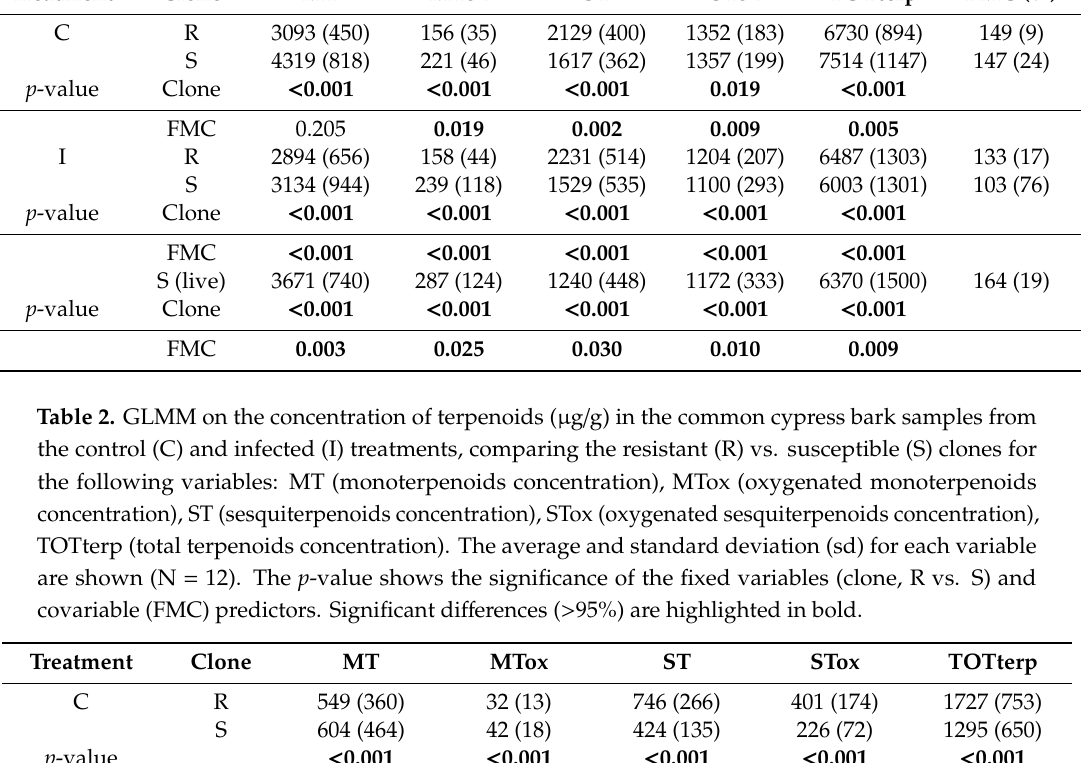
Table 1. Generalized linear mixed models (GLMM) on the concentration of terpenoids ( µ g / g) in common cypress leaf samples from the control (C) and infected (I) treatments comparing the resistant (R) vs. susceptible (S) clones for the following variables: MT (monoterpenoids concentration), MTox (oxygenated monoterpenoids concentration), ST (sesquiterpenoids concentration), STox (oxygenated sesquiterpenoids concentration), TOTterp (total terpenoids concentration). The fuel moisture content (FMC) was used as the covariable. The model for the S clone was repeated removing dead samples (live fuels only)*. The average and standard deviation (in brackets) for each variable are shown (N = 12). The p -value shows the significance of the fixed variables (clone, R vs. S) and covariable (FMC) predictors. Significant di ff erences ( > 95%) are highlighted in bold.